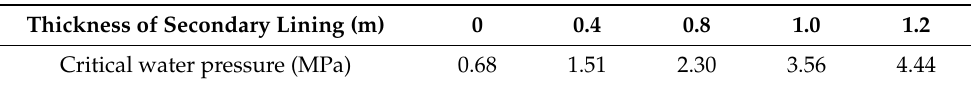
Table 2. Water pressure resistance of composite structures with different second lining